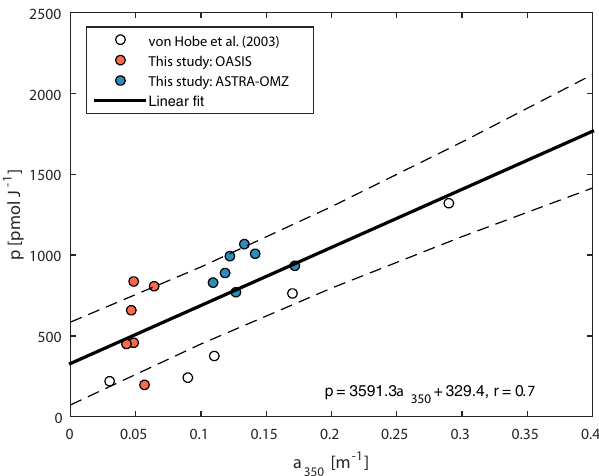
Figure 3. Dependence of photoproduction rate constant p on a 350 including own fits for p (resulting in blue lines in Fig. 2) and fits from a similar study (von Hobe et al., 2003). Dashed lines indicate the 95% confidence